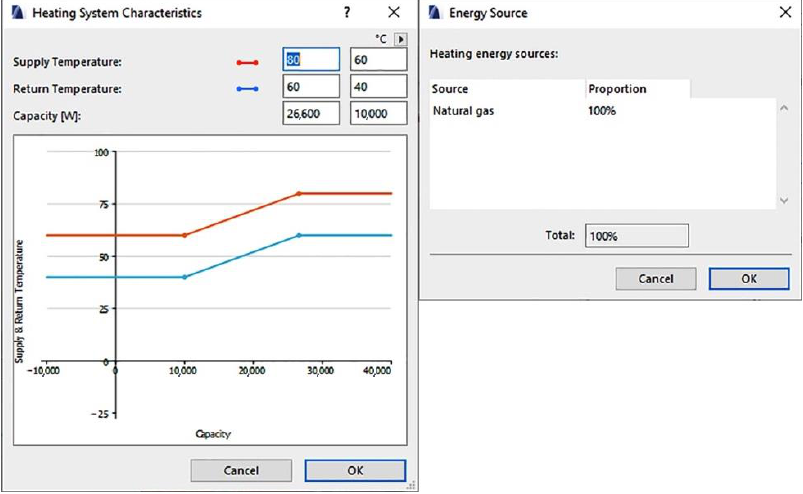
Figure 12. On the left, the window in which the flow and return temperature of the heating system water is set; on the left, the energy source used to power the boiler.